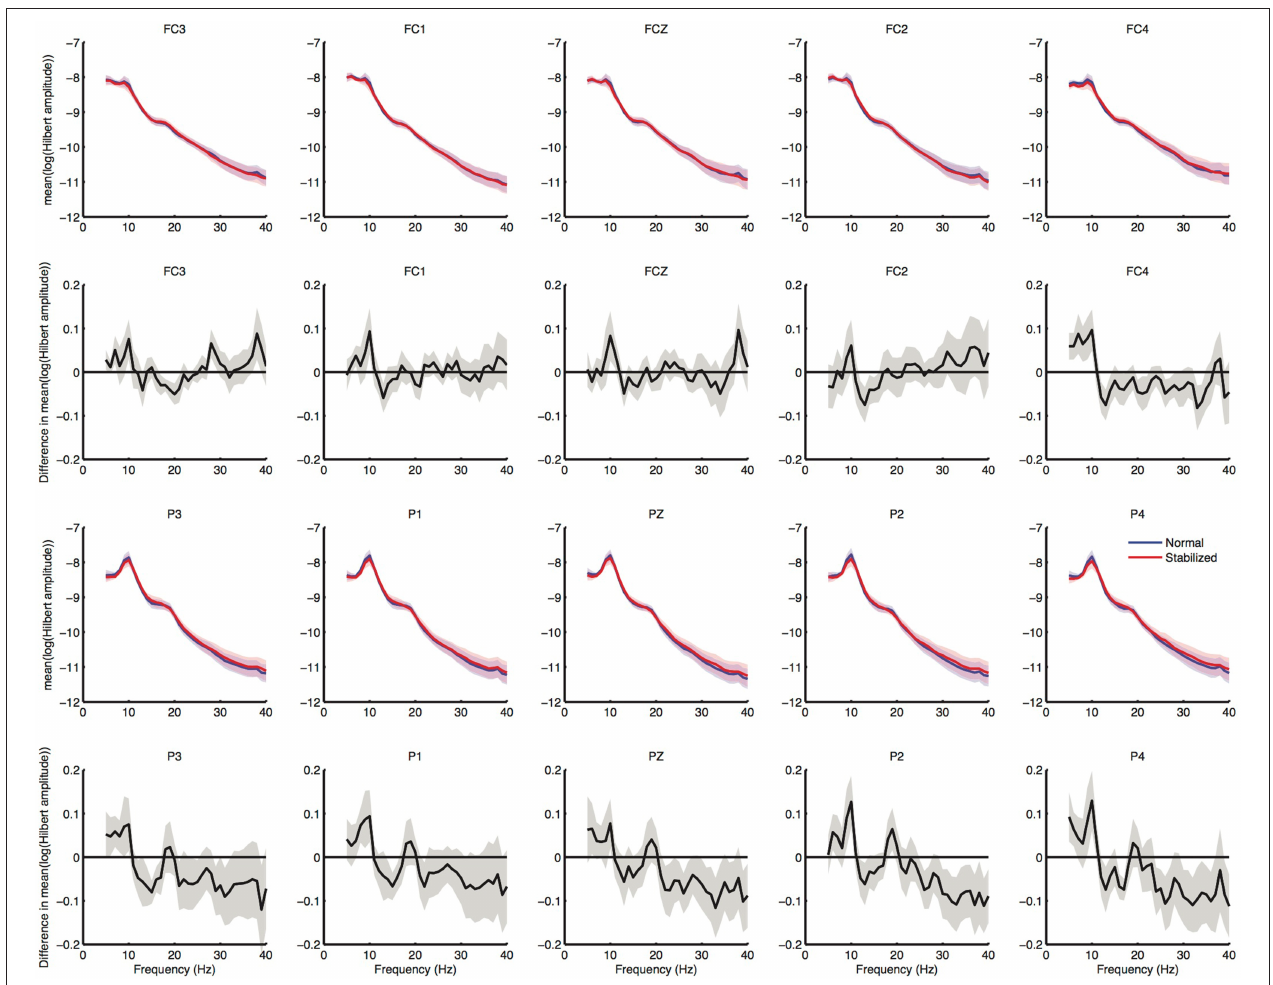
FIGURE 4 | Results of sensor level spectral analysis. First row shows normalized power spectra of electrodes over the premotor area, second row shows difference in power spectra between conditions, in which values below zero represent higher power in the stabilized condition. Third and fourth row shows spectra over posterior electrodes for comparison. Shaded regions represent standard